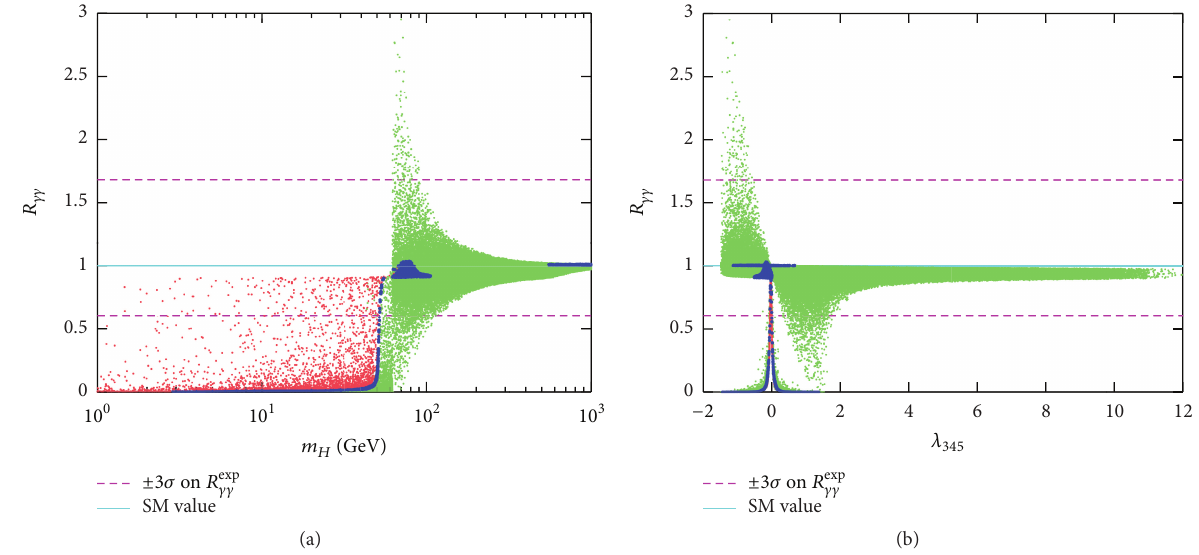
Figure 3: 𝑅 𝛾𝛾 parameter as a function of the DM candidate mass 𝑚 𝐻 (a) and the 𝜆 345 coupling (b), for the same random scan of IHDM parameter